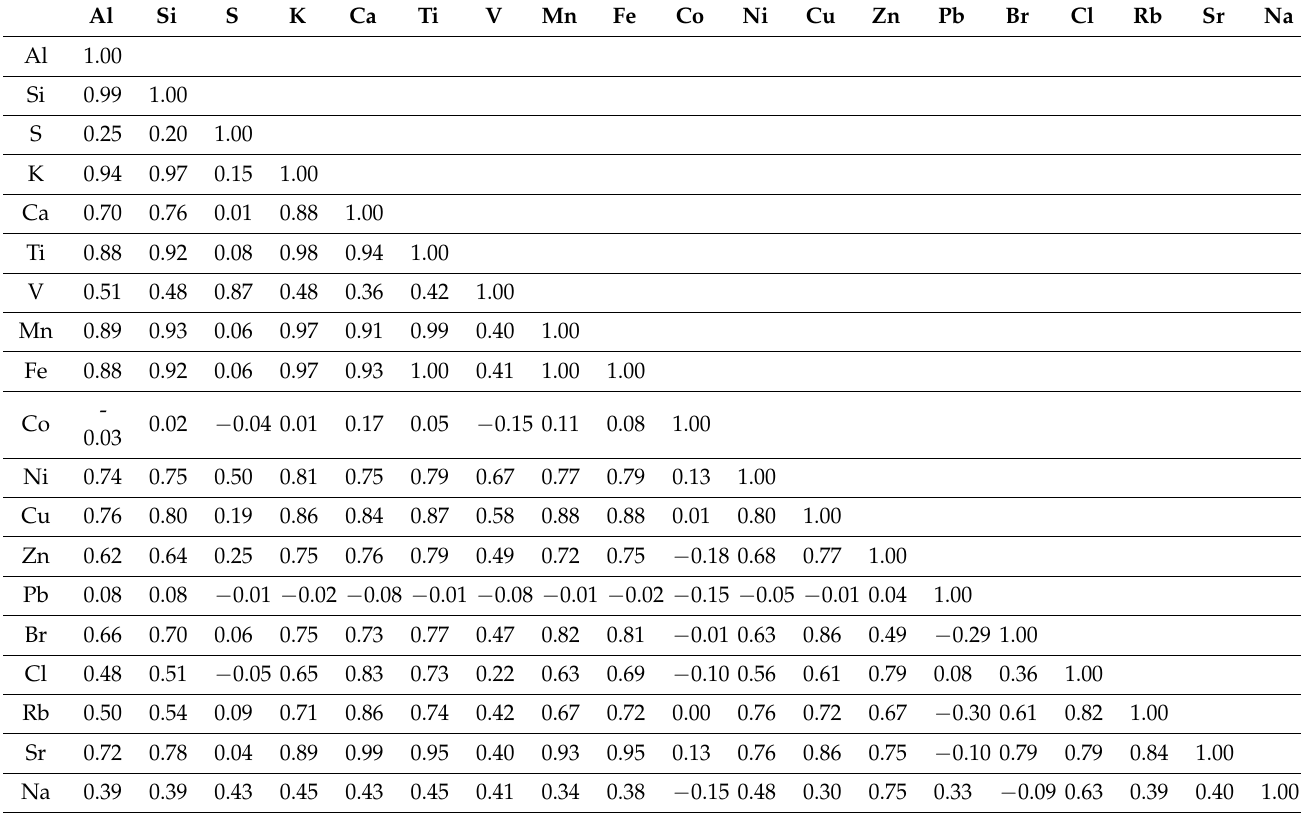
Table 4. The correlation coefficients of Pearson between the quantified elements in the PM 2.5 samples assembled from Alnaeem site.